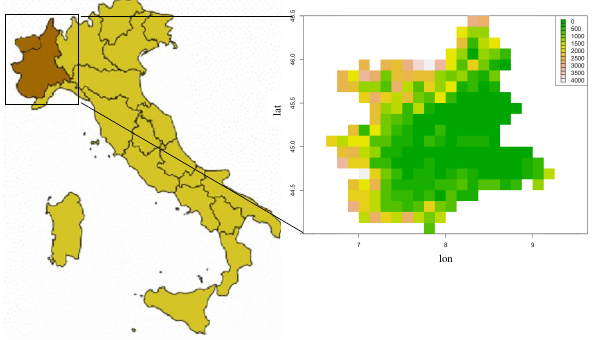
Fig. 2. The optimal interpolation map. In the detailed map the grid- point elevation ( m ) is Fig. 2 the Optimal Interpolation map